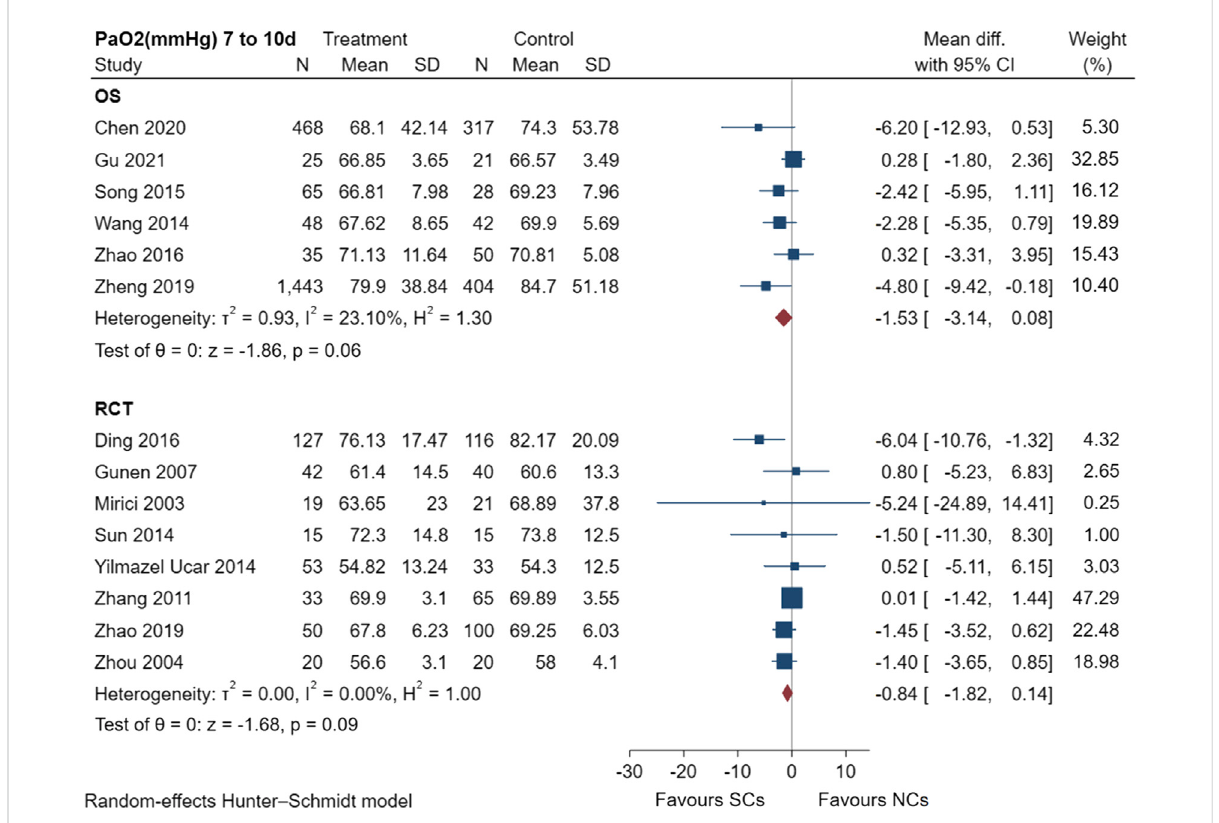
Effectiveness of SCs and NCs on PaO 2 (mmHg) at 7 – 10 days control in observational studies and randomized controlled